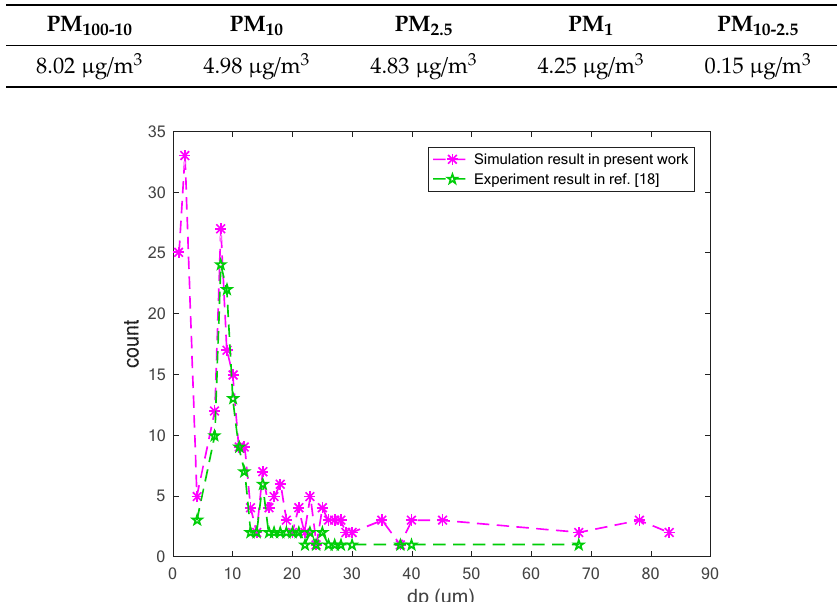
Figure 17. Comparison of the particle size distribution of simulated atmospheric particulate matter with experiment result in ref. [18].